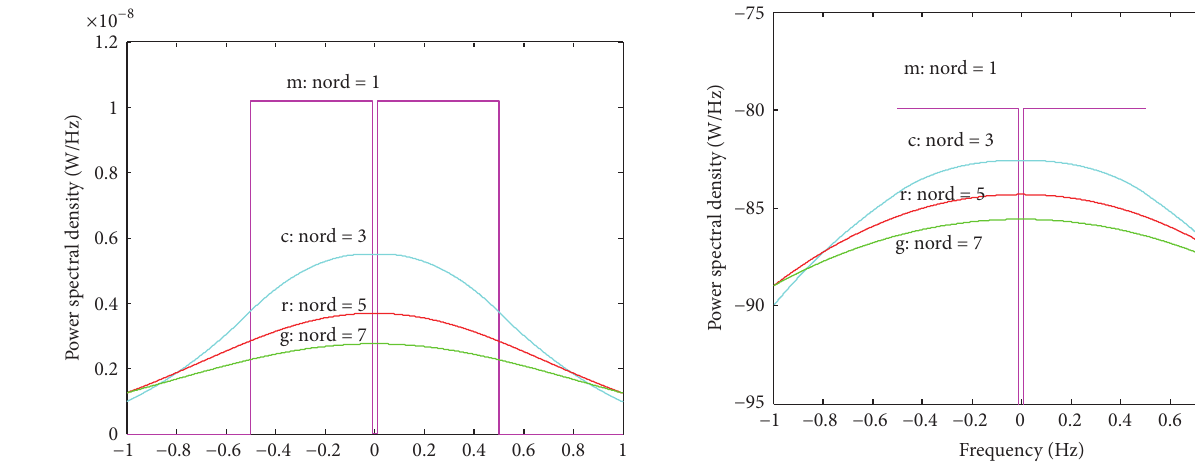
Figure 3: Power spectral density (dBW/Hz) of various order convolution terms over a bandwidth of 200 MHz ( 𝐵 𝑇 = 100 MHz, 𝜎 2 𝐵 notch = 2MHz, and 𝜉 = 1W).